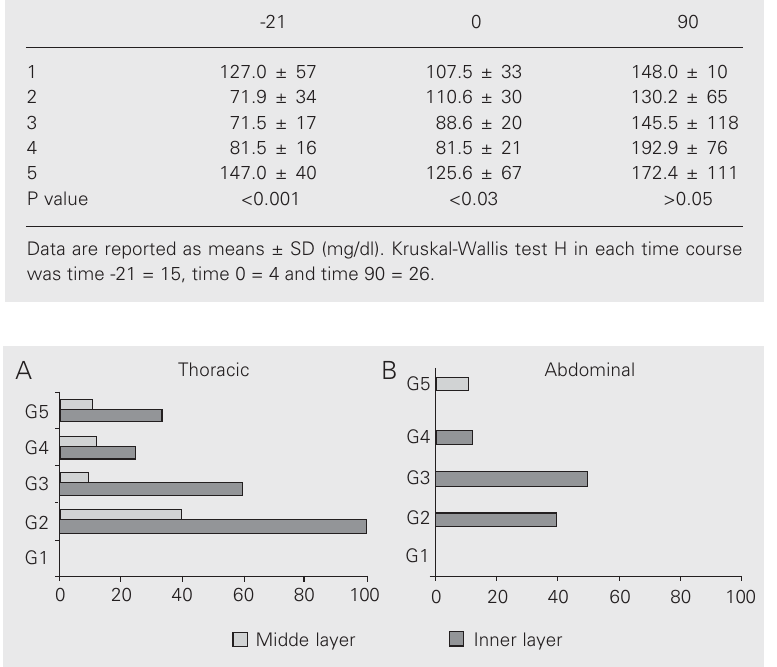
Figure 1. Calcium content of the inner and middle layers of thoracic (A) and abdominal aortic (B) segments. Data are reported as percent of calcium content in each layer. Thoracic segment: χ 2 = 23.13, P = 0.0001 (G1 = G4 = G5) ≠ G2 ≠ G3. Abdominal segment: inner layer χ 2 = 12.52, P = 0.0139* (G1 = G4V) ≠ (G2 = G3); middle layer